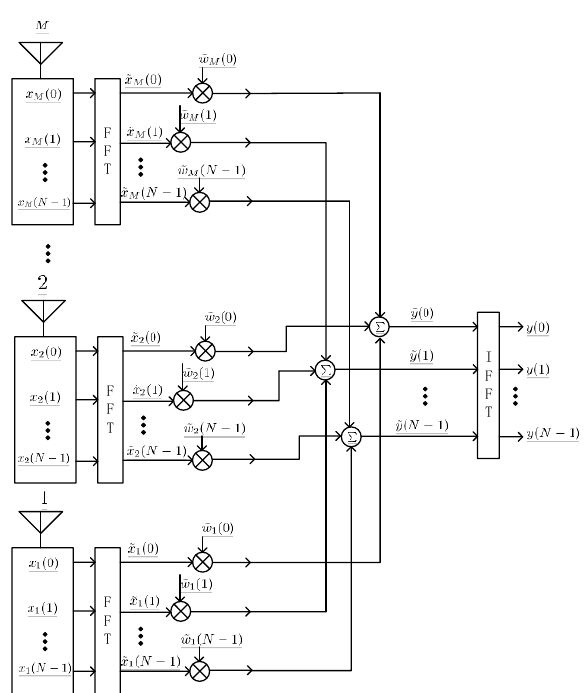
Figure 4. Architecture of the spatial-frequency adaptive processor (SFAP) with M antenna elements and a DFT length of N .